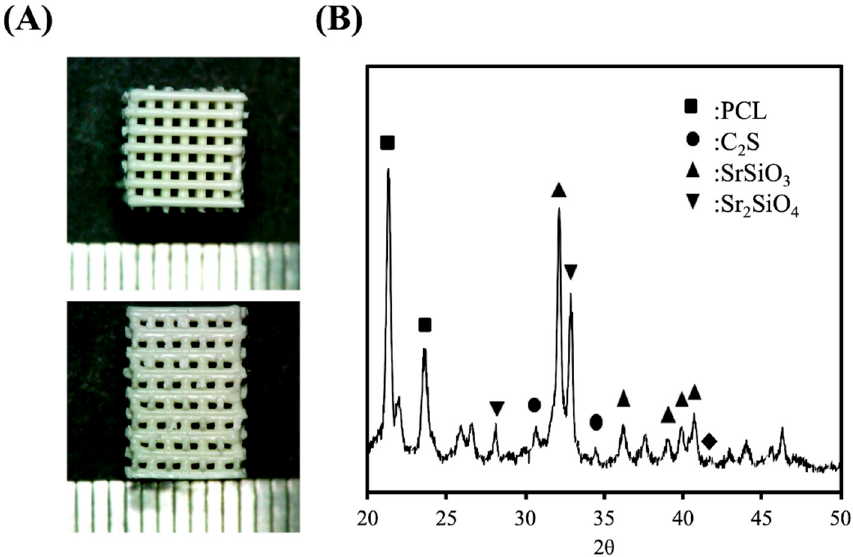
Figure 1. ( A ) Di ff erent view and ( B ) X-ray di ff raction patterns of the 3D printed strontium calcium Figure 1. ( A ) Different view and ( B ) X-ray diffraction patterns of the 3D printed strontium calcium silicate (SrCS) sca ff silicate (SrCS) scaffolds.